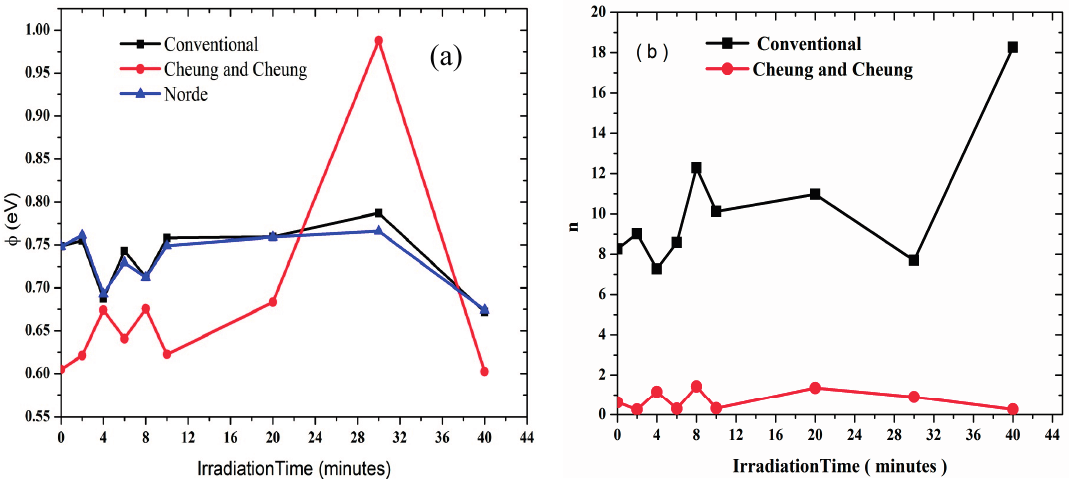
Figure 7. Graphs demonstrating the relationship between ideality factor and barrier height with the radiation